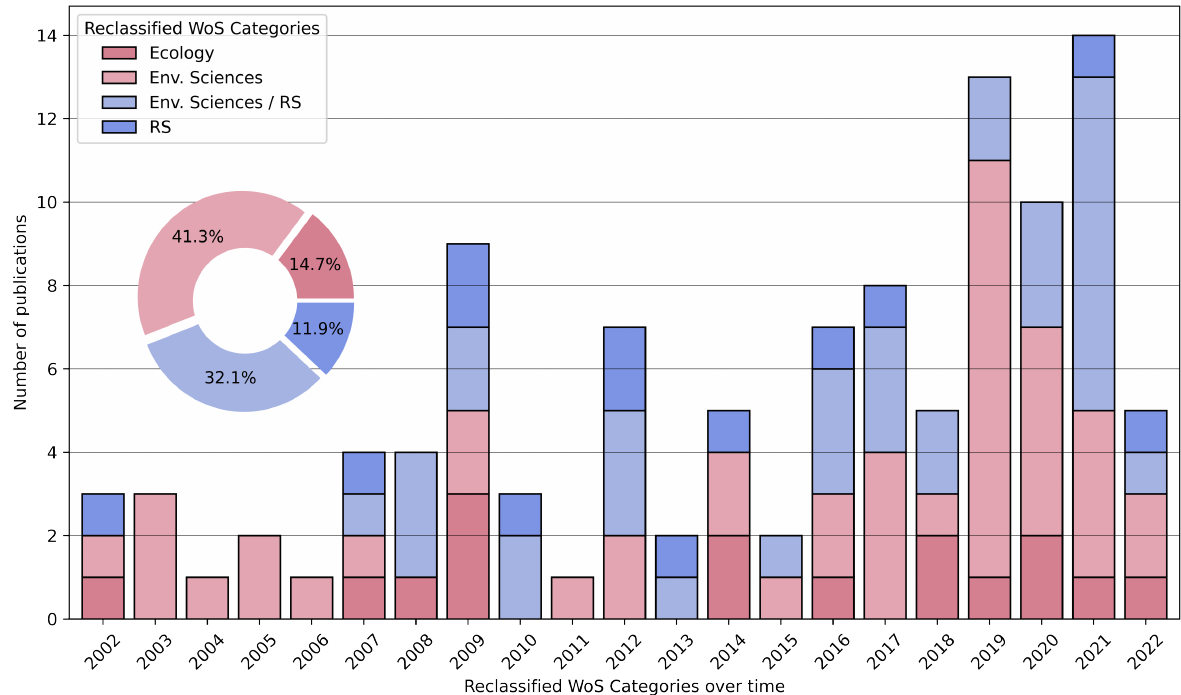
Figure 3. Temporal distribution of publications subdivided into reclassified Web of Science categories. Overall, there is an increasing number of publications from 2002 to 2022 with more than 56% of all studies being published since 2016. About 41% of all studies can be classified as research in “Environ- mental Sciences”, followed by “Environmental Sciences and Remote Sensing” (about 32%).